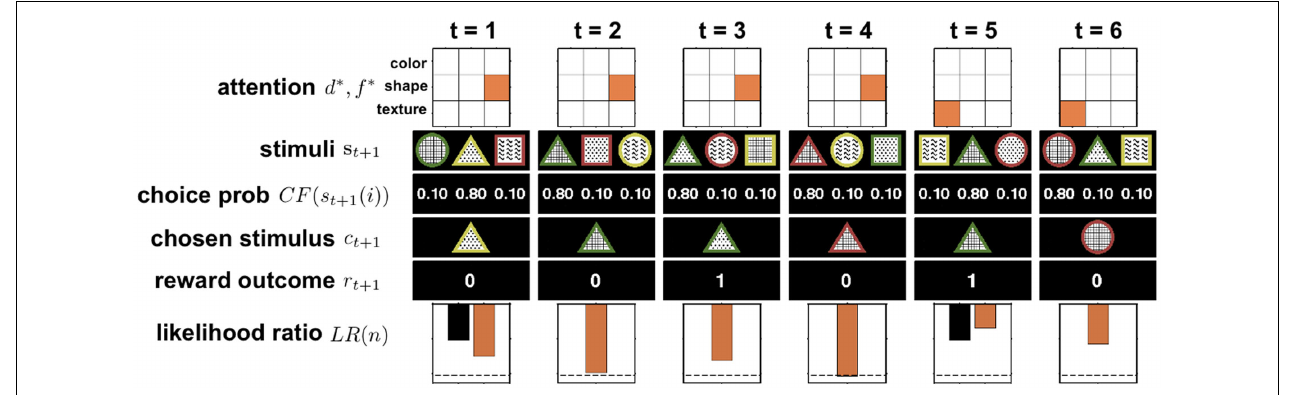
FIGURE 4 | Illustration of six trials of the full selective attention model in action. At t = 1 the model randomly picks one dimension-feature ( d ∗ , f ∗ ) pair, in this case (shapes, triangle), to attend to.Then the three stimuli s t + 1 = { s t + 1 (1), s t + 1 (2), s t + 1 (3)} are observed and ε -greedy choice probabilities are computed (in this example ε = 0.3). Next a stimulus is chosen, c t + 1 , and the reward outcome, r t + 1 , observed.The observed reward is used to update